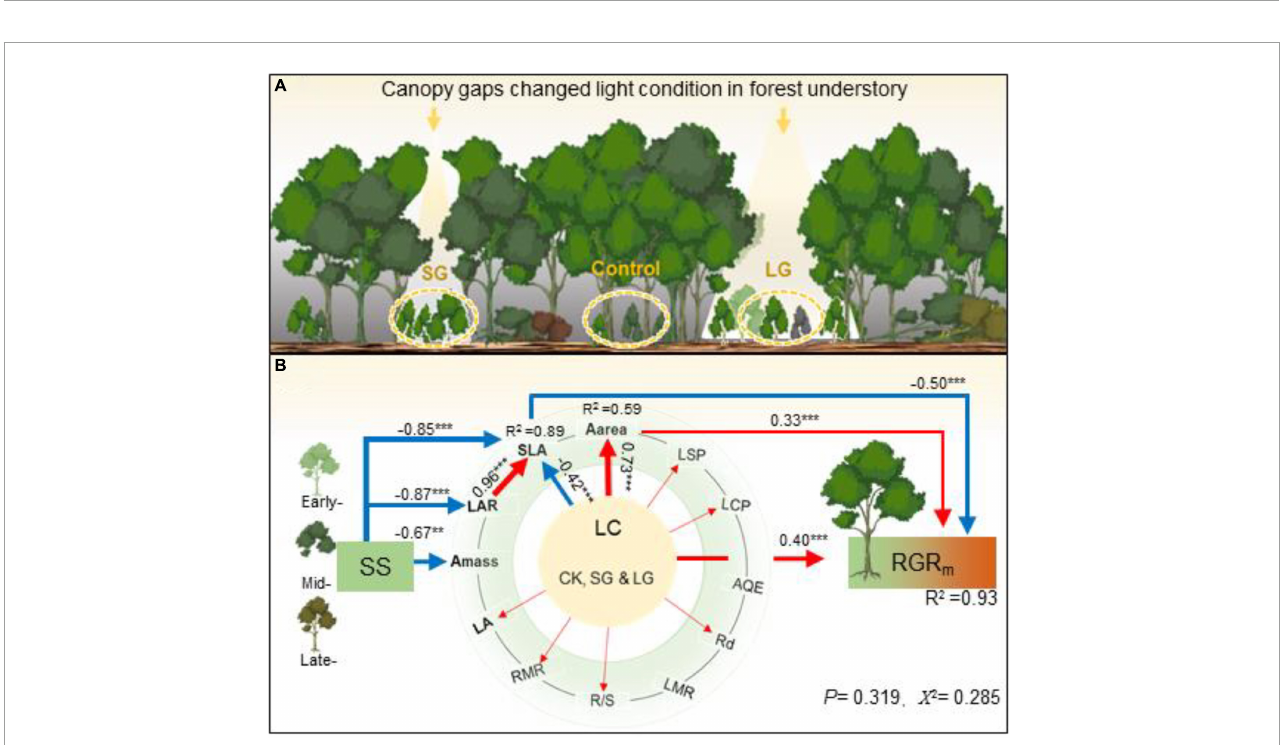
FIGURE5 Illustration of disturbance-caused canopy gaps’ impact on light condition (LC, i.e., Control, SG, and LG) in forest understory (A) , and their effects on seedlings’ relative mass growth rate [RGR m , (B) ] for tree species at different successional stage (SS, i.e., early-, mid-, and late- successional stage) based on the path analysis. Control, 0–5% of full sunlight; SG: small canopy gaps, 10–15% of full sunlight; LG: large canopy gaps, 40–50% of full sunlight. In path analysis, “1,” “2”, and “3” were assigned to treatments of Control, SG and LG; and species at early-, mid-, and late-successional stage, respectively. The red and blue arrows indicate significantly positive and negative effects of light condition (LC), successional stage (SS), leaf area (LA), specific leaf area (SLA), dark respiration (R d ), light saturation point (LSP), light compensation point (LCP), apparent quantum efficiency (AQE), mass-, and area- based light saturated rate of CO 2 assimilation (A mass and A area ), leaf mass ratio (LMR), root mass ratio (RMR) and root: shoot ratio (R/S) on RGR m ( P < 0.05), respectively. Symbols **, *** indicate statistical significance at P < 0.01 and 0.001. In Chi-square test for the path model, the P -value (0.319, > 0.05) calculated from one-tailed test indicated that model fit had been